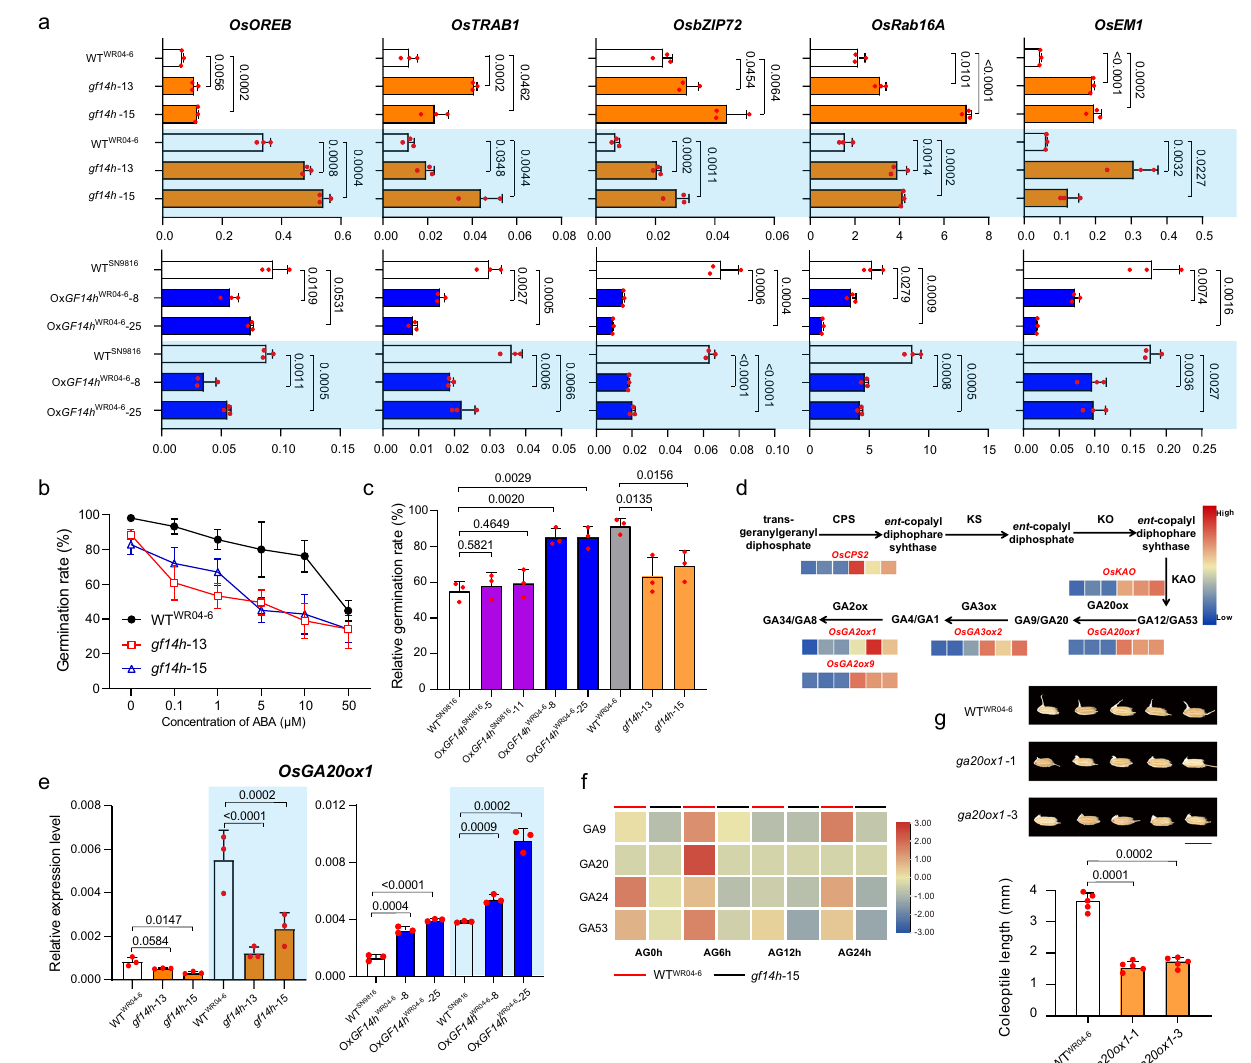
Fig. 4 | OsGF14h WR04-6 inhibits ABA response and enhances GA biosynthesis. a The relative expressionofABAregulated and responsive genes between WT WR04-6 and OsGF14h knockout lines, between WT SN9816 and OsGF14h overexpression lines under anaerobic (blue background) and aerobic conditions at the 12h. b Assay of exogenous ABA with gradient concentrations to re fl ect the ABA sensitivity for OsGF14h knockout lines and WT WR04-6 . Error bars indicate the means±SD of three independent experiments. c Comparison of relative germination rate between WT SN9816 and two types of overexpression lines (function and partial loss-of-func- tion) and between WT WR04-6 and OsGF14h knockout lines under 72h of anaerobic incubation with exogenous 1 µ M ABA treatment. In b , c seeds with the embryo showing white without the emergence of coleoptile are still considered as germi- nation. d The expression model of six DEGs on the GA biosynthesis pathway is presented based on RNA sequencing. The left three and right three rectangles under the gene names (highlighted in red) represent the FPKM value of the three